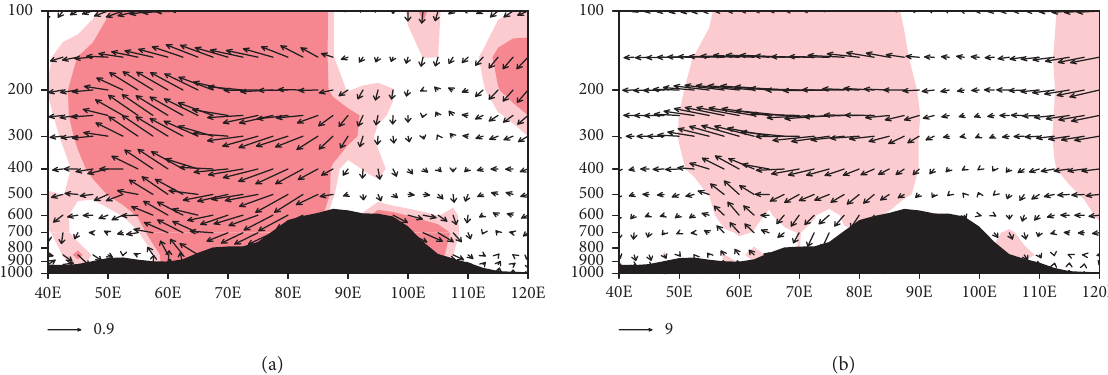
Figure 8: (a) Simultaneous correlation between I ° N. (b) Composite anomalies of W and the zonal vertical circulation averaged over 30–37.5 the zonal vertical circulation averaged over 30–37.5 ° N between the high- I W and low- I W years. The dark (light) shading in (a) indicates the correlation coefficients significant at the 99% (95%) confidence level. The shading in (b) indicates the zonal vertical circulation anomalies significant at the 95% confidence